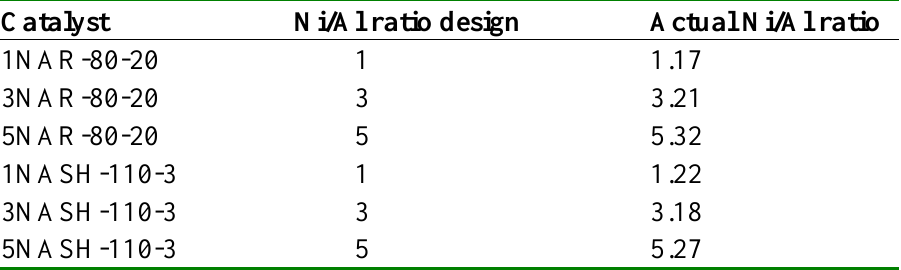
Table 1. The molar ratio of Ni/Al hydrotalcite-like compounds.